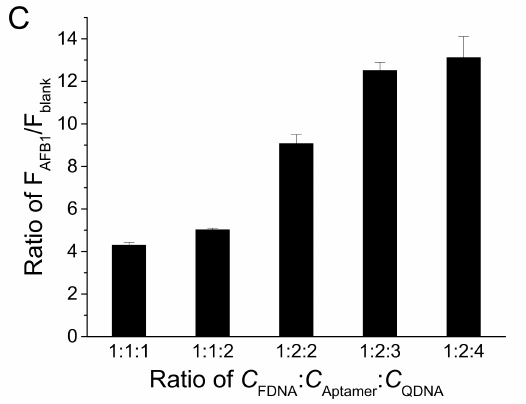
Figure 4. Effects of different concentration ratios between FDNA, aptamer, and QDNA ( C FDNA : C Aptamer : C QDNA ) on ( A ) fluorescence intensity of samples, ( B ) quenching efficiency, and ( C ) ratio of F AFB1 /F blank . Assay buffer was 10 mM Tris-HCl (pH 7.5) solution containing 50 mM MgCl 2 , 50 mM NaCl, and 0.1% Tween 20. FDNA concentration was fixed at 50 nM. AFB1 concentra- tion was 200 nM. Af27 and Af27-C13Q were used as aptamer and QDNA, respectively. Incubation at 4 ◦ C for 60 min was